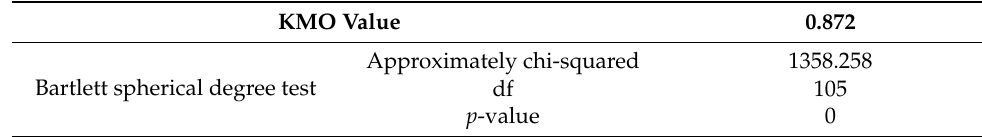
Table 4. KMO and Bartlett’s